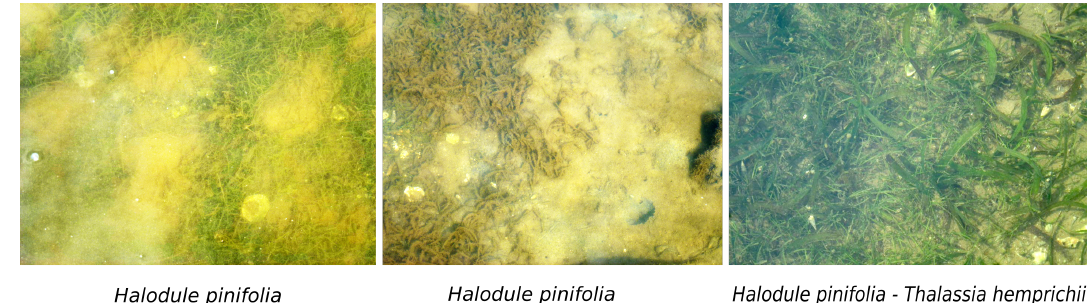
Figure 2. Seagrass meadows in the centre of Vietnam (16 ◦ 13 (cid:48) –16 ◦ 42 (cid:48) N, 107 ◦ 21 (cid:48) –108 ◦ 5 (cid:48) E). These photos were taken by H.N. Thang